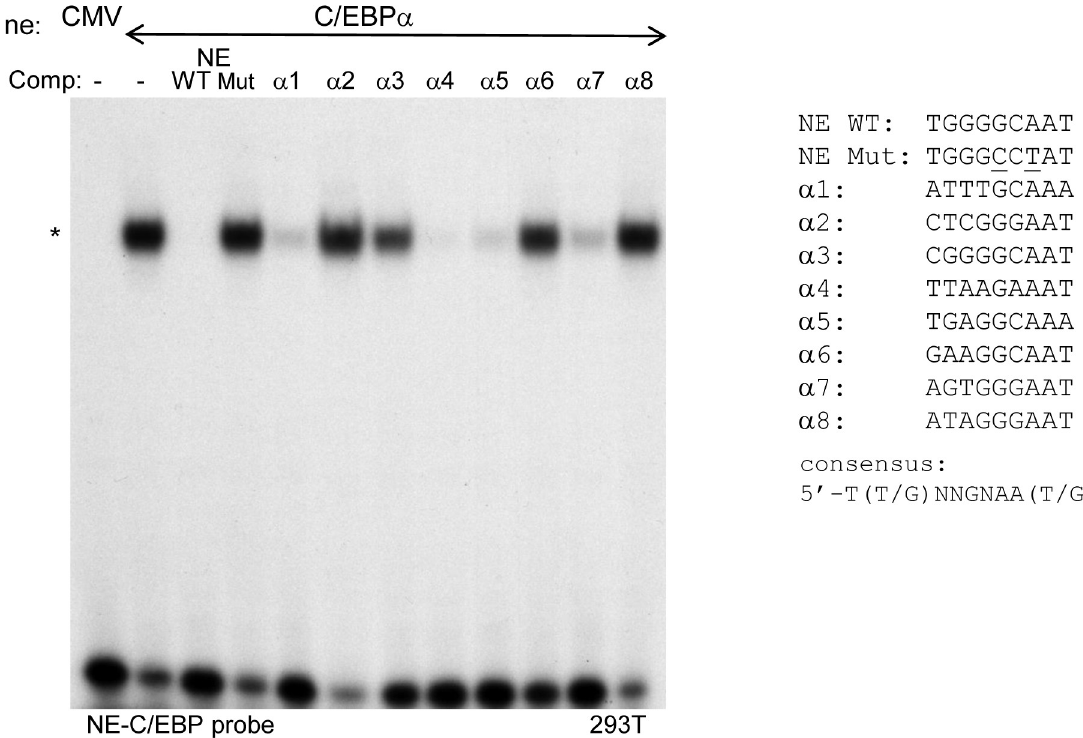
Fig 5. C/EBP α binds five sites within the Cebpa +8 kb enhancer. 1 ng of radio-labeled NE-C/EBP probe, containing a C/EBP α -binding site, was incubated with 10 μ g of nuclear extract prepared from 293T cells transfected with empty CMV vector or with a vector expressing C/EBP α , alone or with 25 ng of the indicated unlabeled competitor double-stranded DNAs, followed by PAGE and autoradiography. The position of the shifted species is indicated ( � ). The sequences of the C/EBP-binding motifs within the competitors are shown with mutant bases underlined.